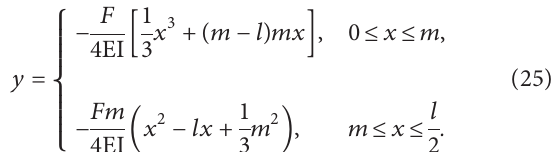
Figure 6: Damage mode of the PSL